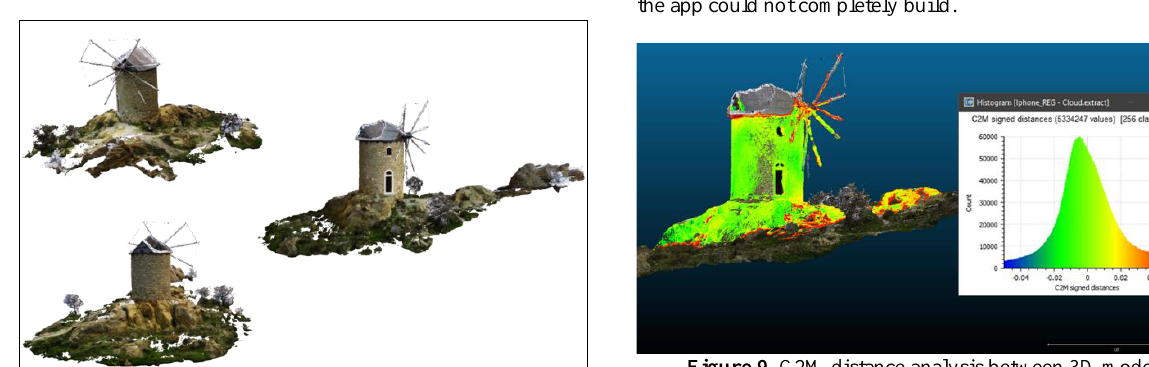
Figure 7. 3D model views of windmill from PPK-aided Terrestrial Photogrammetry approach